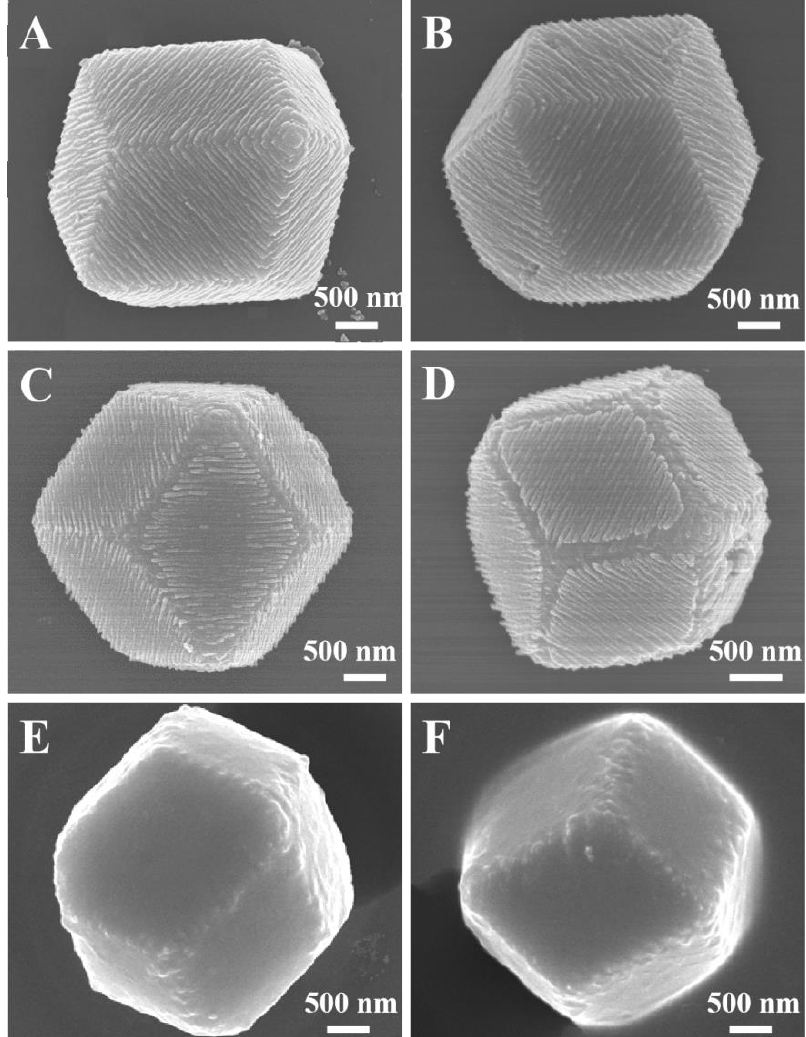
Figure 4. Typical SEM images of HSANs, such as rhombic dodecahedra, grown from a 5 M AgNO 3 aqueous solution with different irradiation time: ( A , B ) 60 min, ( C , D ) 70 min, ( E , F ) 95 min. To further investigate the growth process of the HSANs, we adjust the reaction